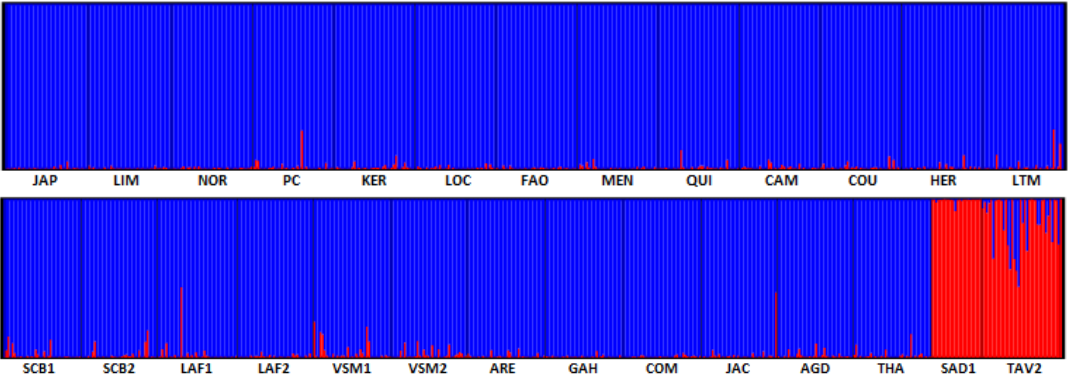
Figure 5. Individual Bayesian assignment proportion for K = 2 clusters. The abbreviation of the populations are given in Table 1. Blue and red colors correspond to the C. gigas and C. angulata genetic backgrounds respectively.